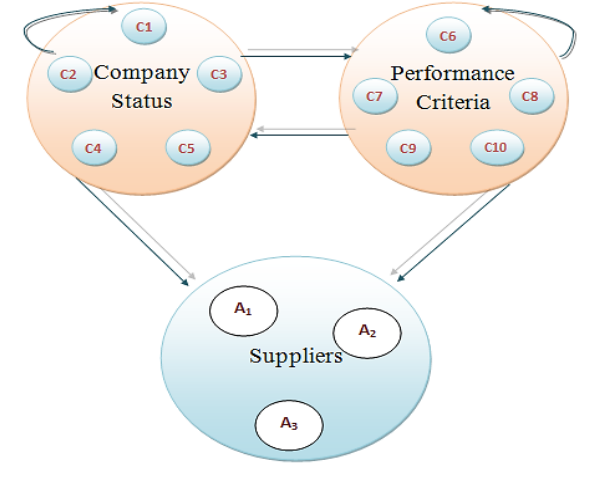
Fig. 5. Final diagraph of effects of criteria and suppliers on each other.g. 5. Final diagraph of effects of criteia and suppliers on each other.